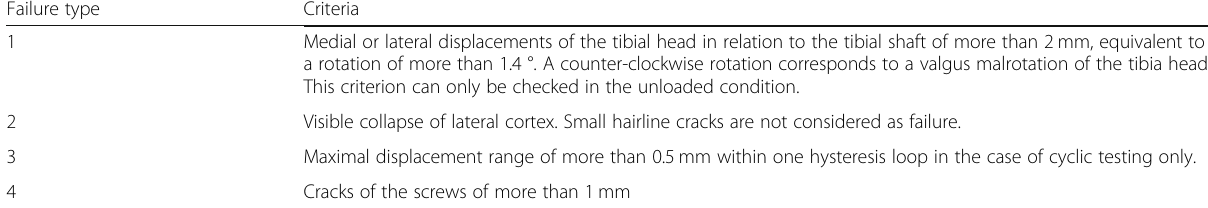
Table 4 Used failure types and their defining criteria (Maas et al. 2013; Diffo Kaze et al. 2015; Diffo Kaze 2016; Diffo Kaze et al. 2017) Failure